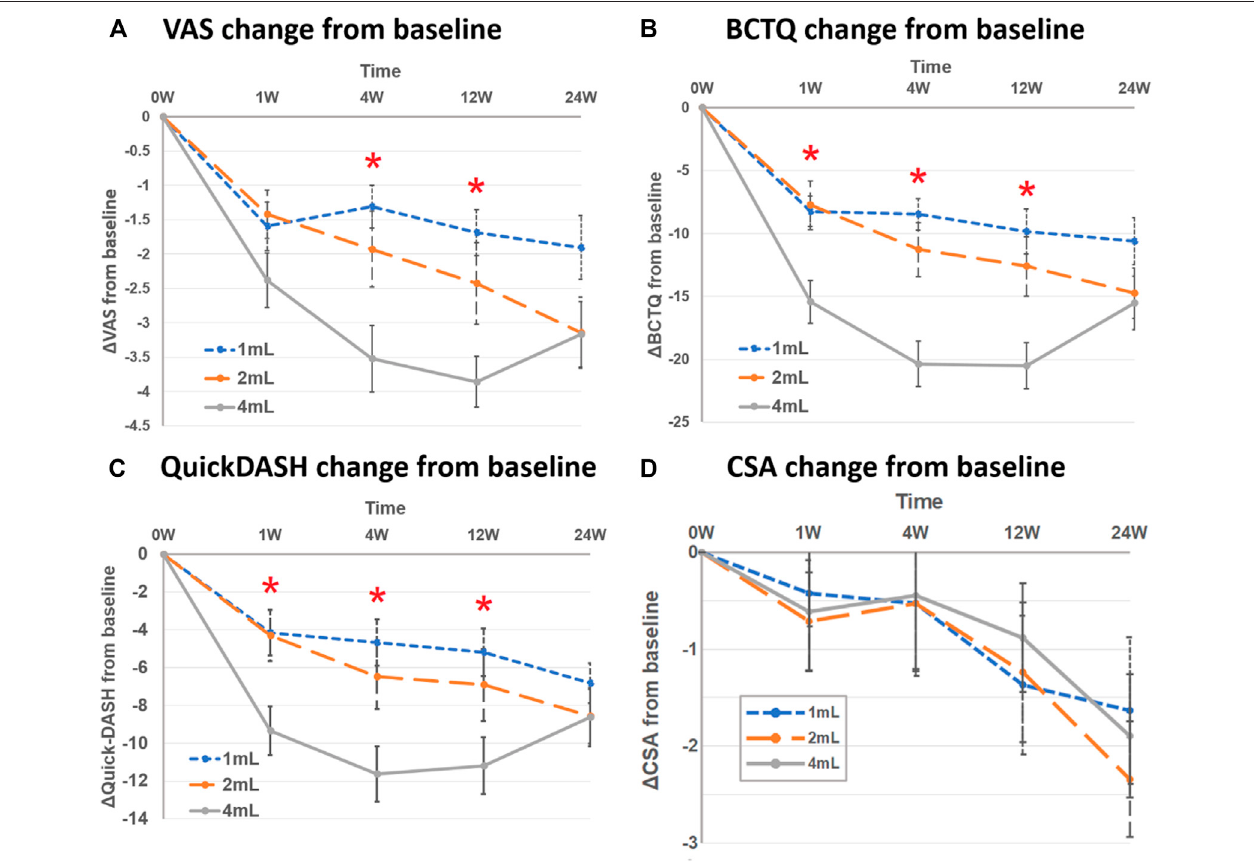
FIGURE 2 | Mean change from baseline between three groups at follow-up time points (1st, 4th, 12th and 24th week) in (A) visual analog scale (VAS), (B) Boston CarpalTunnelSyndromeQuestionnaire(BCTQ)scores, (C) QuickDASH, and (D) cross-sectionalareaofmediannerve(CSA). Asteriskrepresented signi fi cantdifference between three groups.